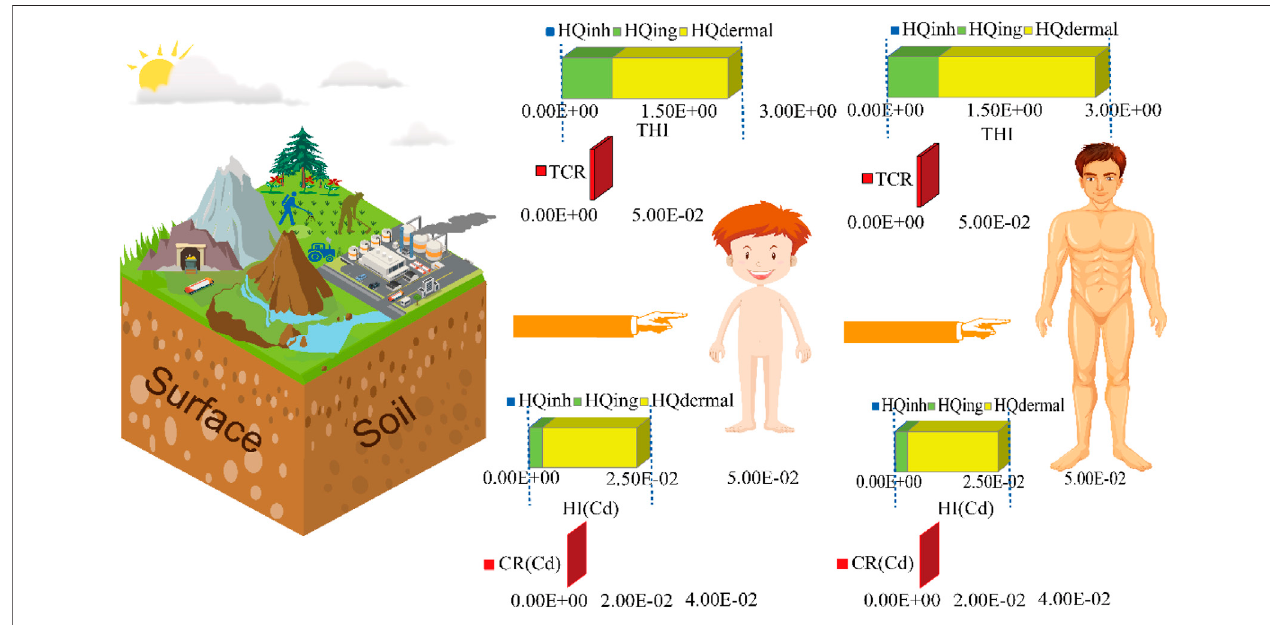
FIGURE 5 | Health risks of heavy metals in surface